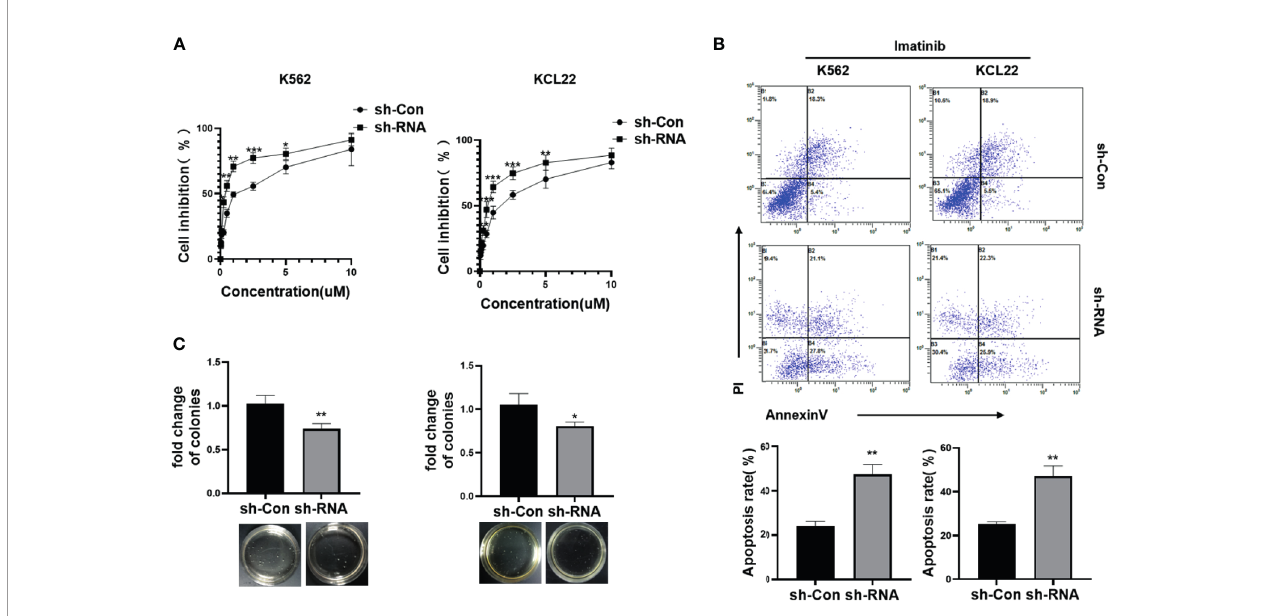
FIGURE 3 | HNRNPH1 knockdown increases imatinib sensitivity in CML cells. (A) K562 and KCL22 cells were transfected with speci fi c sh-RNA of HNRNPH1 or negative sh-RNA (sh-Con) and treated with different imatinib concentrations for 48 h. CCK-8 analysis was used to detect cell inhibition. ***P < 0.001, **P < 0.01 vs . sh-Con. (B) K562 and KCL22 cells were transfected with speci fi c sh-RNA of HNRNPH1 or negative sh-RNA (sh-Con) and treated with imatinib (3 µM) for 48 h. Cell apoptosis was detected by fl ow cytometry using Annexin V/FITC/PI. The right panel shows the apoptosis rate from three independent experiments. **P < 0.01 vs . sh-Con. (C) CML cells were prepared as (B) , and cell proliferation was detected by colony formation assay. *P < 0.05, **P < 0.01 vs . sh-Con. The bottom panel shows an image of